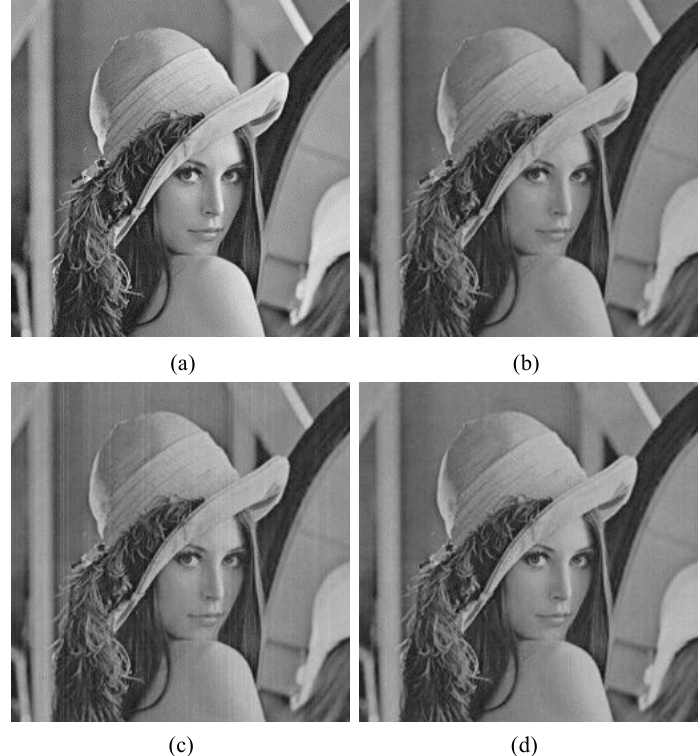
Figure 9. ( a ) The standard 256 × 256 image “lena”; ( b ) a reconstructed image contaminated by shot noise and read noise ( U n = 0.15e − ) without the mismatch of a 1-bit ADC transition point ( U th = 0.5) for m = 16 and z = 16, and the grayscale similarity index (GSI) is 0 LSB; ( c ) a reconstructed image with a transition point mismatch, U thn = 0.15e- added on the basis of ( b ), and the GSI is 3.31 LSB; ( d ) a